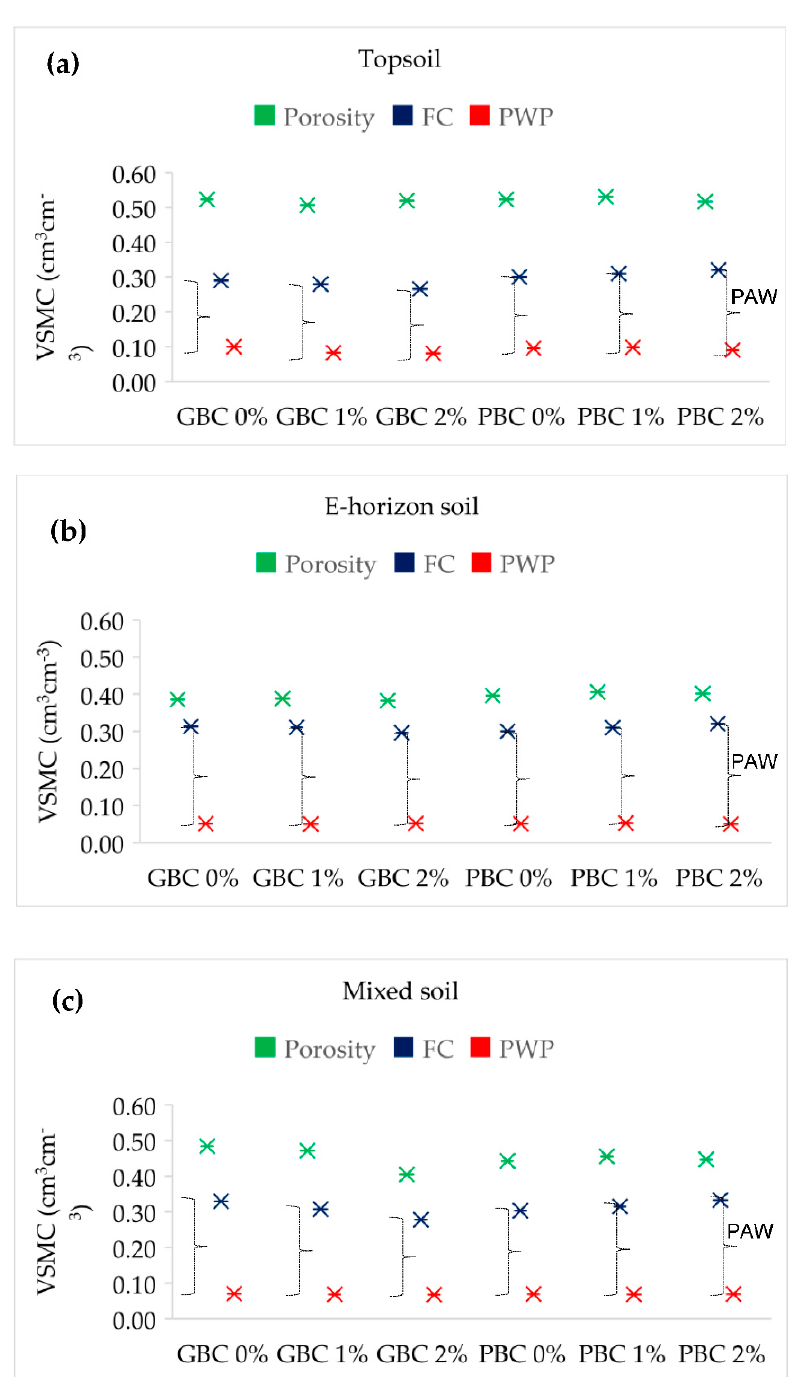
Figure 5. Effect of biochar amendment on porosity, field capacity (FC), permanent wilting point (PWP) and plant available water (PAW) in different types of soil: ( a ) topsoil; ( b ) E-horizon soil and ( c ) mixed soil. Abbreviations: GBC—granular biochar; PBC—powder biochar; VSMC—volumetric soil moisture content; the symbol “ } ” indicated PAW which is the difference between FC and PWP.